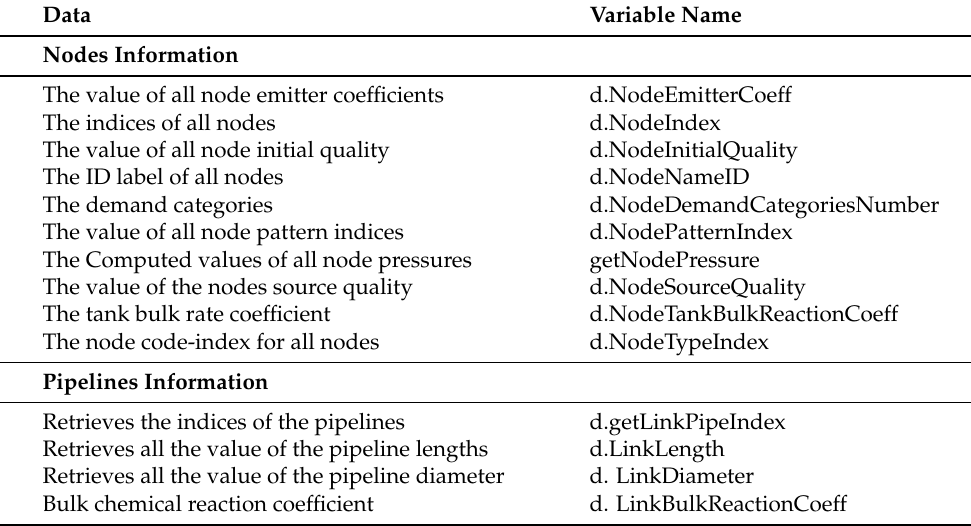
Table 1. Available data that can be used in the